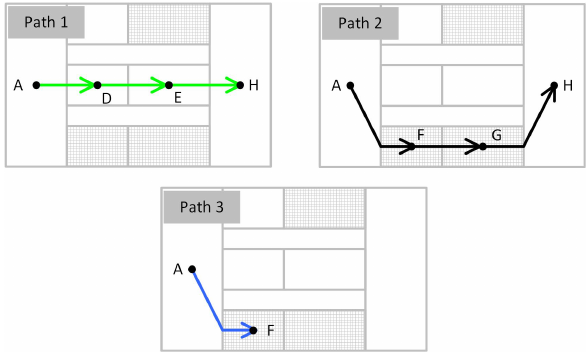
With the navigation network and weights, three navigation paths from S A (departure) to S H (destination) are planned (Figure 5), in which path 1 ( S A → S D → S E → S H ) is the traditional shortest path, path 2 ( S A → S F → S G → S H ) is the MTC-path, and path 3 ( S A → S F ) is the NSI-path.